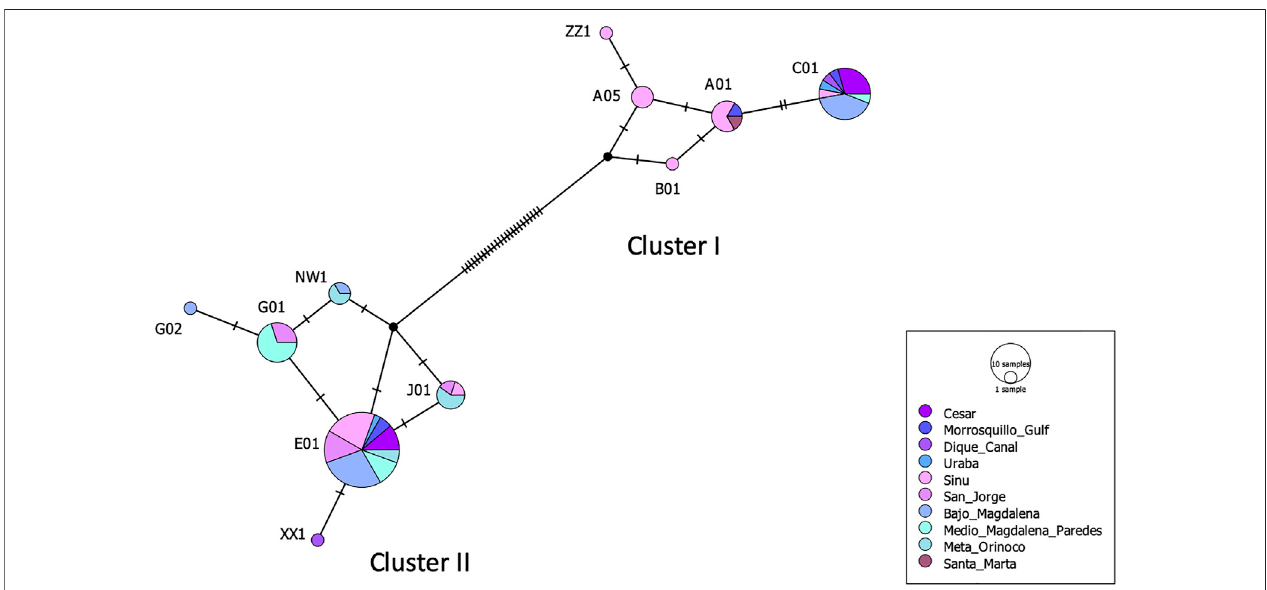
FIGURE 3 | Haplotype network for Trichechus manatus from Colombian sampling sites obtained from the TCS analysis. The size of the circle represents the frequency of each haplotype. Cluster I and II refer to haplotype clusters previously de fi ned for T. manatus by Vianna et al. (2006) and Satizbal et al. (2012).